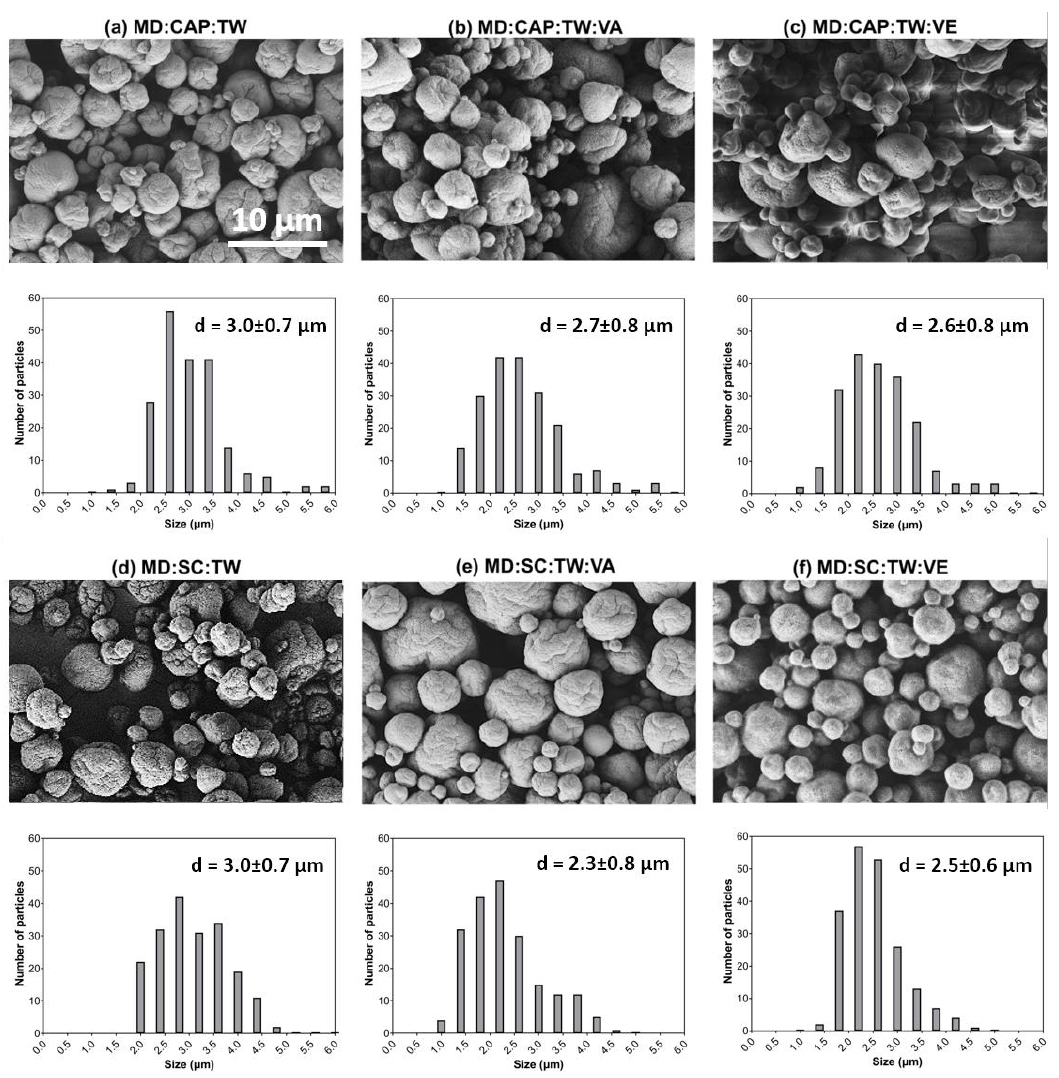
Figure 1. Scanning electron micrographs and histograms of particle size of vitamins encapsulated and